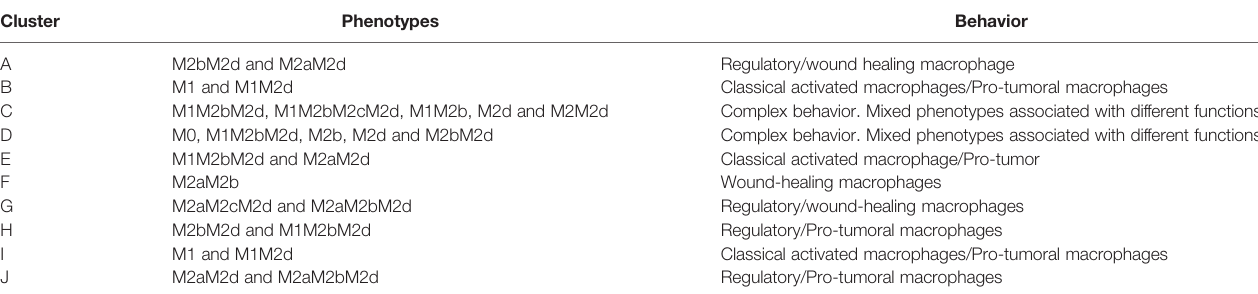
TABLE 2 | Macrophage phenotypes associated with each